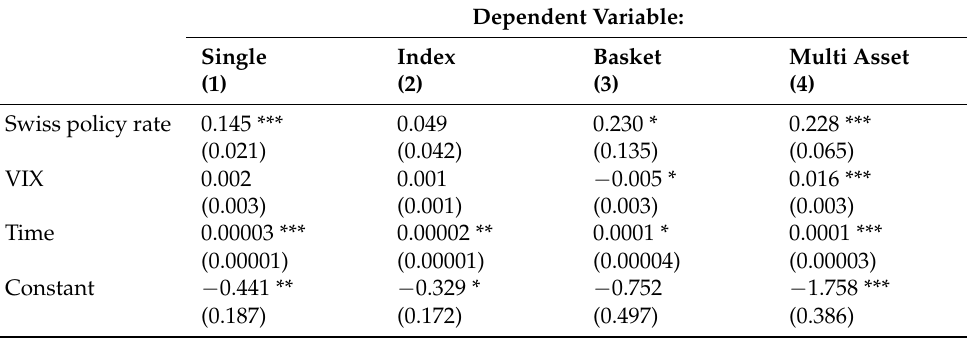
Table 3. Influence of the interest rate on the issuance of capital protected products with single, basket and index